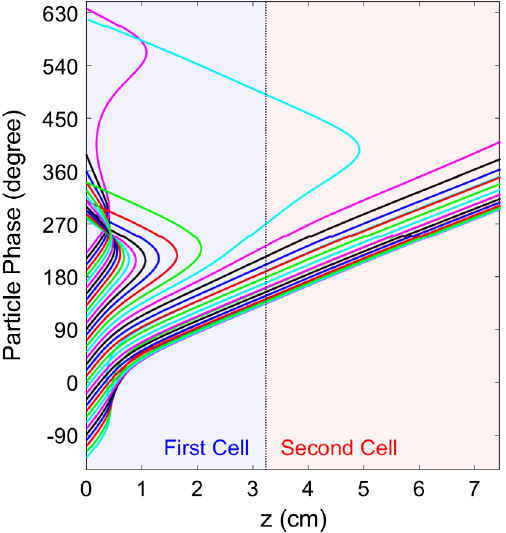
FIG. 3. Applegate diagram of an existing standard commercial